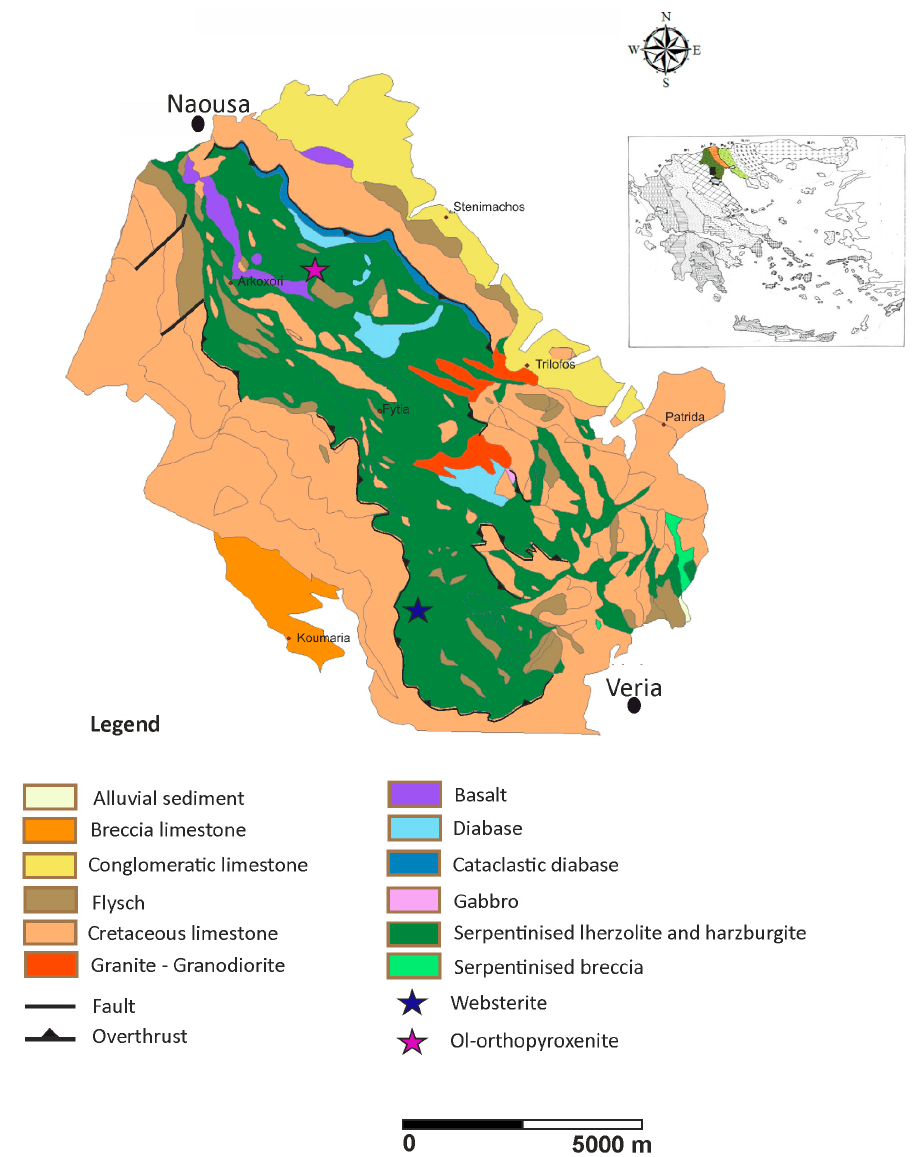
Figure 1. Geological map of the Veria-Naousa region. Inset shows the geotectonic zones of Greece highlighting the Almopias, Paikon and Peonias (from west to east) subzones of the Axios zone; black rectangle shows the study area.